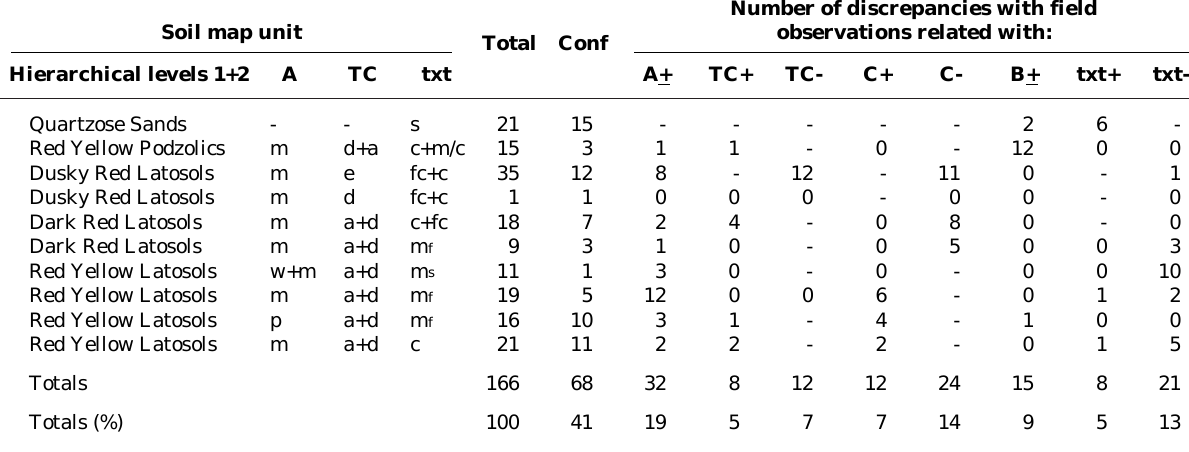
Number of discrepancies with field observations related with: